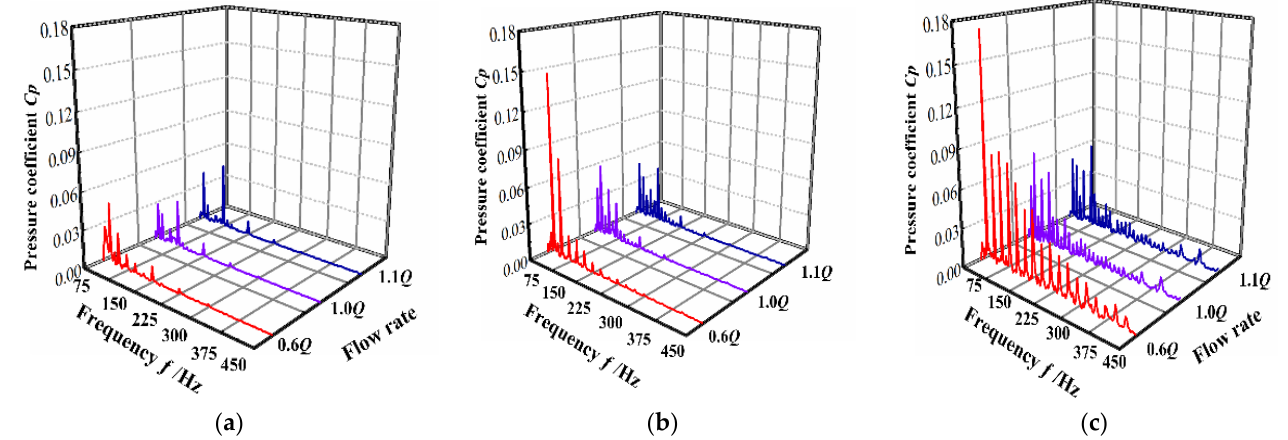
Figure 11. Frequency domain diagram of single-suction impeller at three typical flow rate condi- tions. ( a ) SP4, ( b ) SP5, ( c ) SP6.